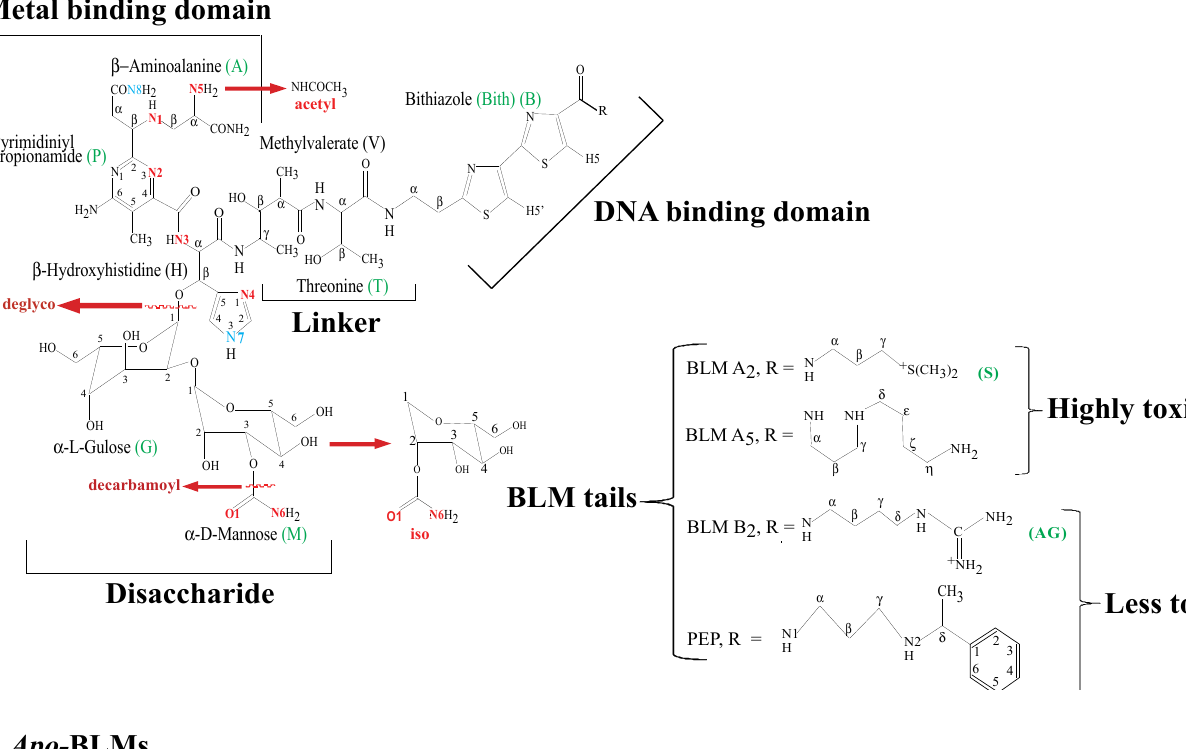
, -A , -B , and PEP. The coordinating atoms postulated by 2 5 2